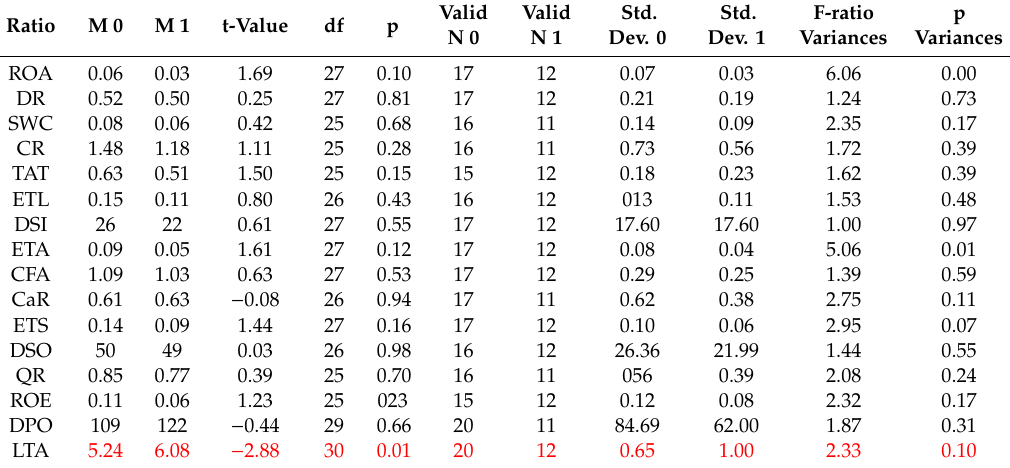
Table A2. The student’s t-test results for the chosen ratios for green (1) and red (0) companies for